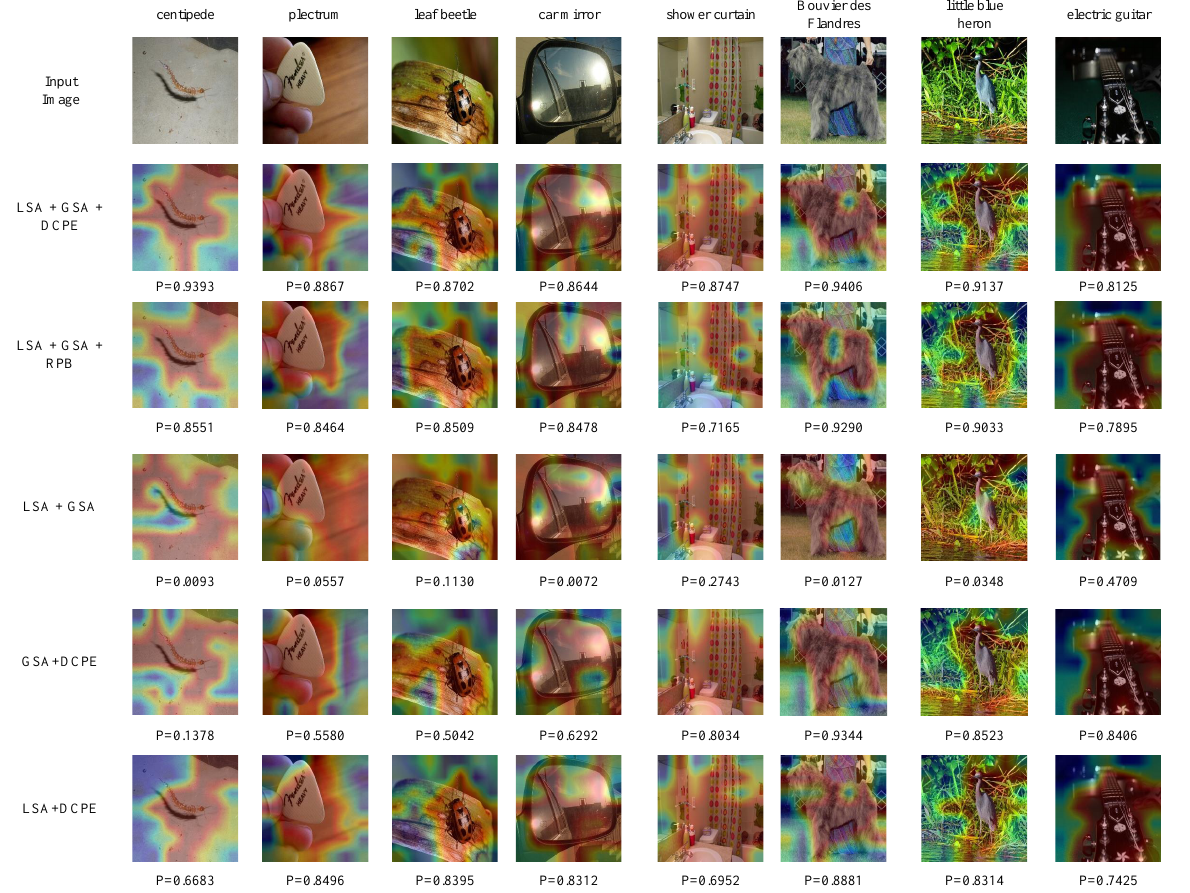
Figure A3. Another visualization of heat map calculated by Grad-CAM. As can be seen, when GSA outperforms LSA, the model without position bias performs better (the fifth and the last column). This phenomenon again shows that the location information mainly exists in local features, thus the model with only LSA shows more potential than the model with only GSA on dense prediction tasks as shown in Table